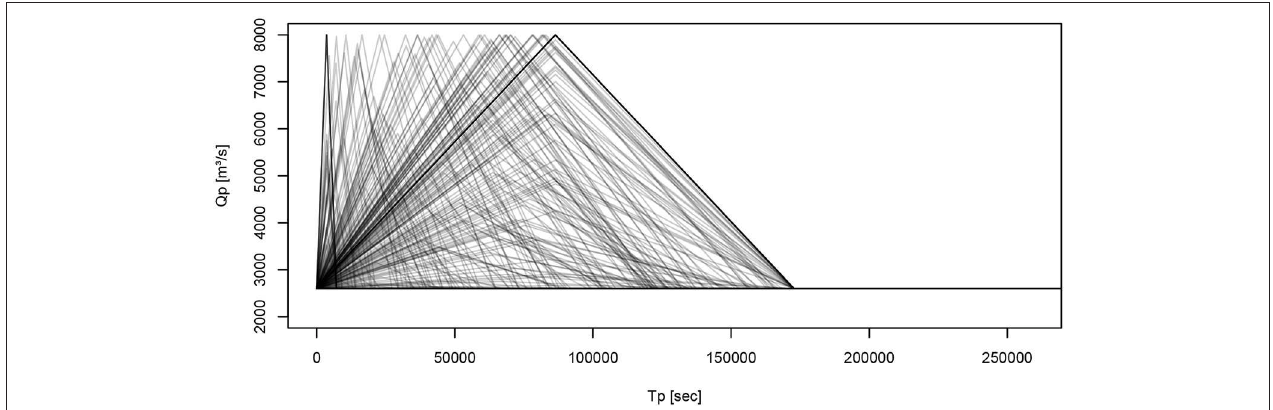
FIGURE 12 | Focused (expected penalizing) flow hydrographs ( T p , Q p